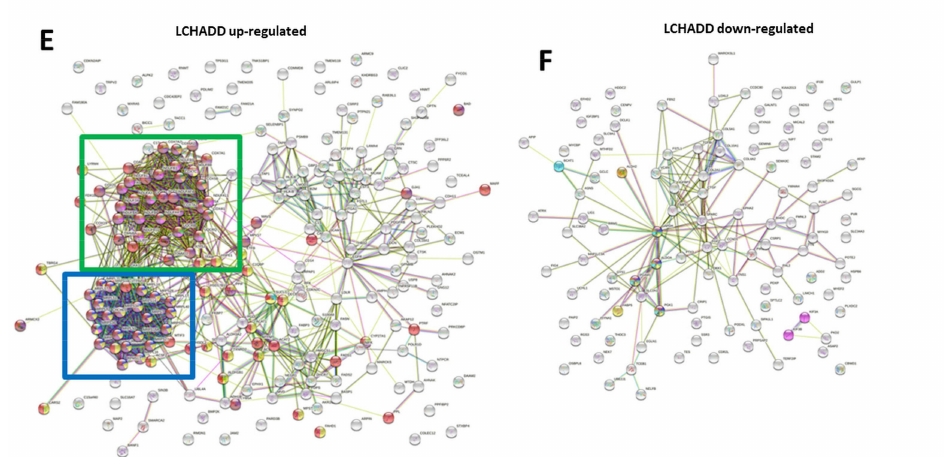
Figure 3. Disease-specific differently expressed proteins under control conditions. ( A , B ) Clas- sification of the biological processes performed using the GO ontology enrichment software (http://geneontology.org/page/go-enrichment-analysis; accessed on 12 March 2021) [21,22]. ( C , D ) Up- and down-regulated VLCADD protein network identified via STRING software (http://www. string-db.org/; accessed on 12 May 2021). ( E , F ) Up- and down-regulated LCHADD protein network identified via STRING software (http://www.string-db.org/; accessed on 12 May 2021). A full list of the up- and down-regulated proteins is reported in Table